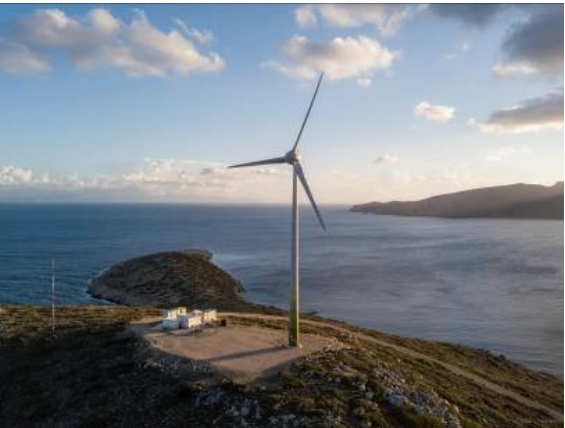
Figure 15. Photo of the Tilos HPS wind turbine, installed in the northwestern part of the island. Table 1. Main characteristics of installed wind turbine.